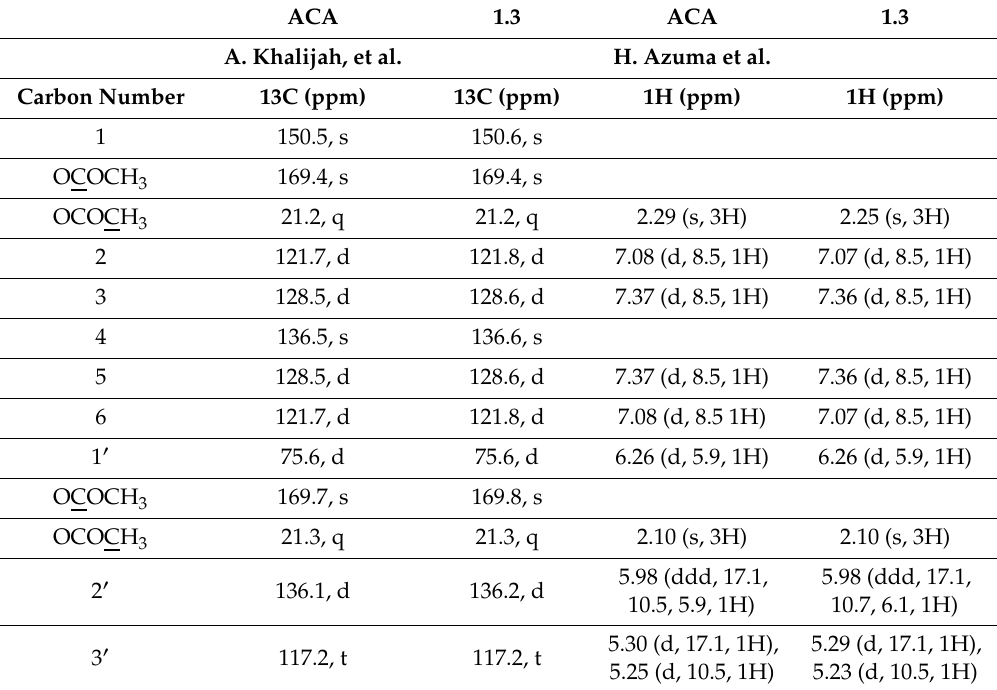
Table 2. The 1H NMR and 13C NMR chemical shifts of 1 (cid:48) S-1 (cid:48) -Acetoxychavicol acetate (ACA) and fraction No. 1.3 ( δ in ppm). ACA 1.3 ACA 1.3 A. Khalijah, et al. H. Azuma et al. Carbon